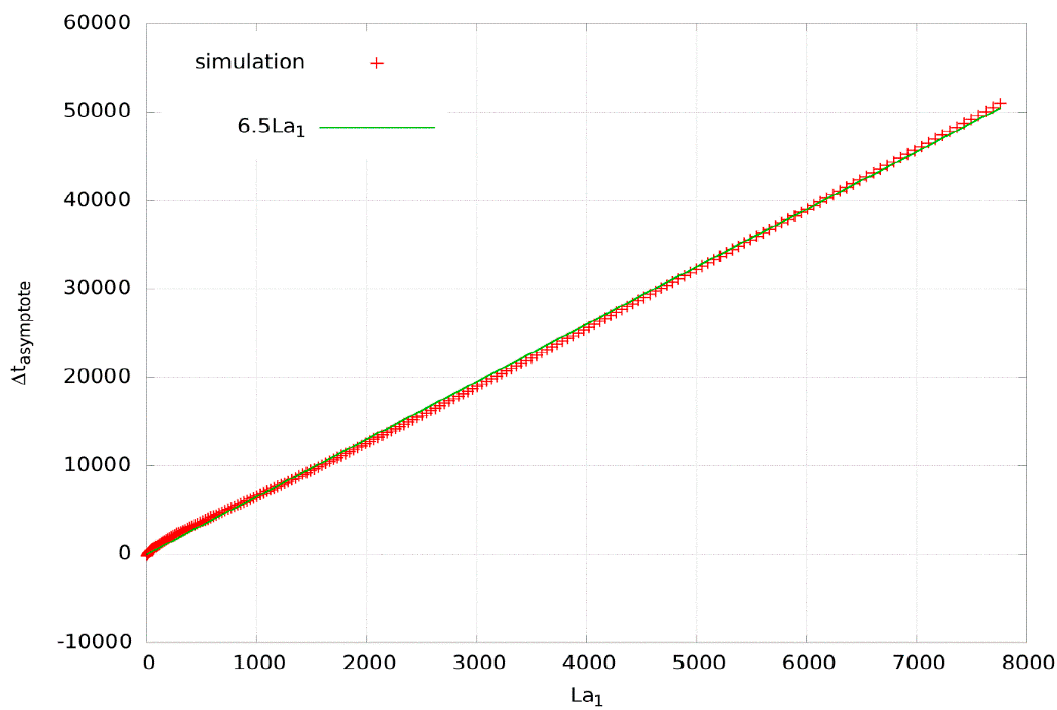
Figure 5. The experimental relation between L 1 a and the delay of the mass permeation asymptote. Calculated numerically for different values of the diffusion coefficients and/or lengths of the tubing. The units of time are irrelevant for linear relation.